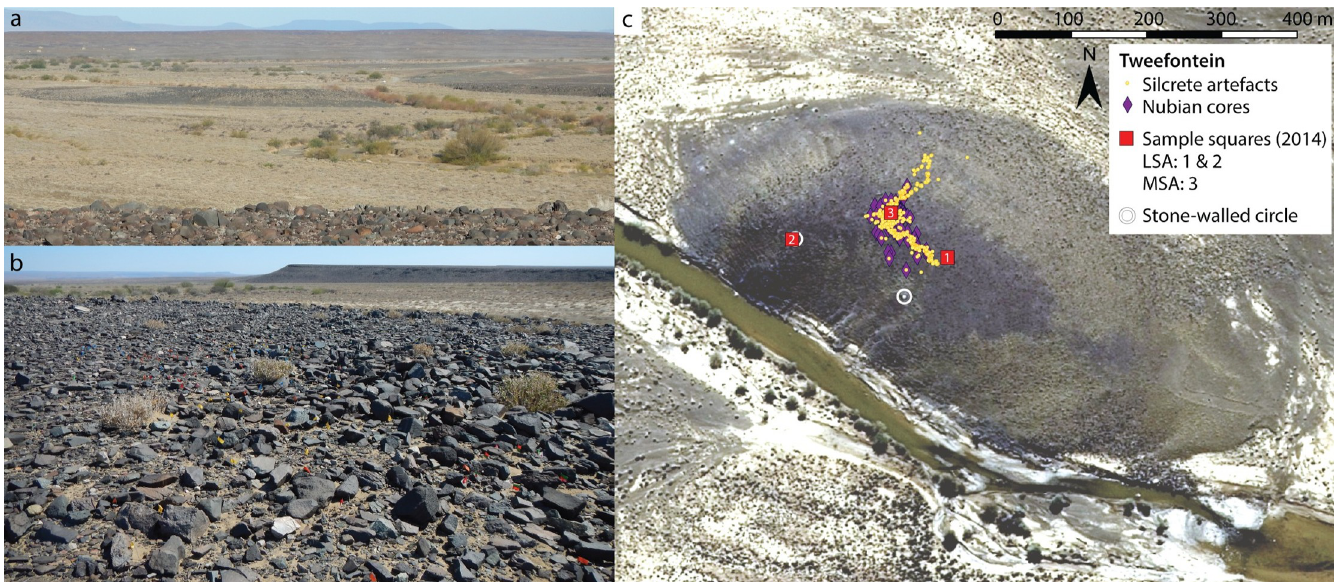
Fig 3. Tweefontein site views. (a) South-east of Tweefontein from the high ridge to the north; (b) north at the site showing flagged artefacts on the desert pavement; (c) aerial view showing silcrete artefacts recorded in 2014 transects and Nubian cores recorded in both 2014 and 2015. Aerial image supplied by National Geo-Spatial Information (Department of Rural Development and Land Reform, Mowbray, South Africa).